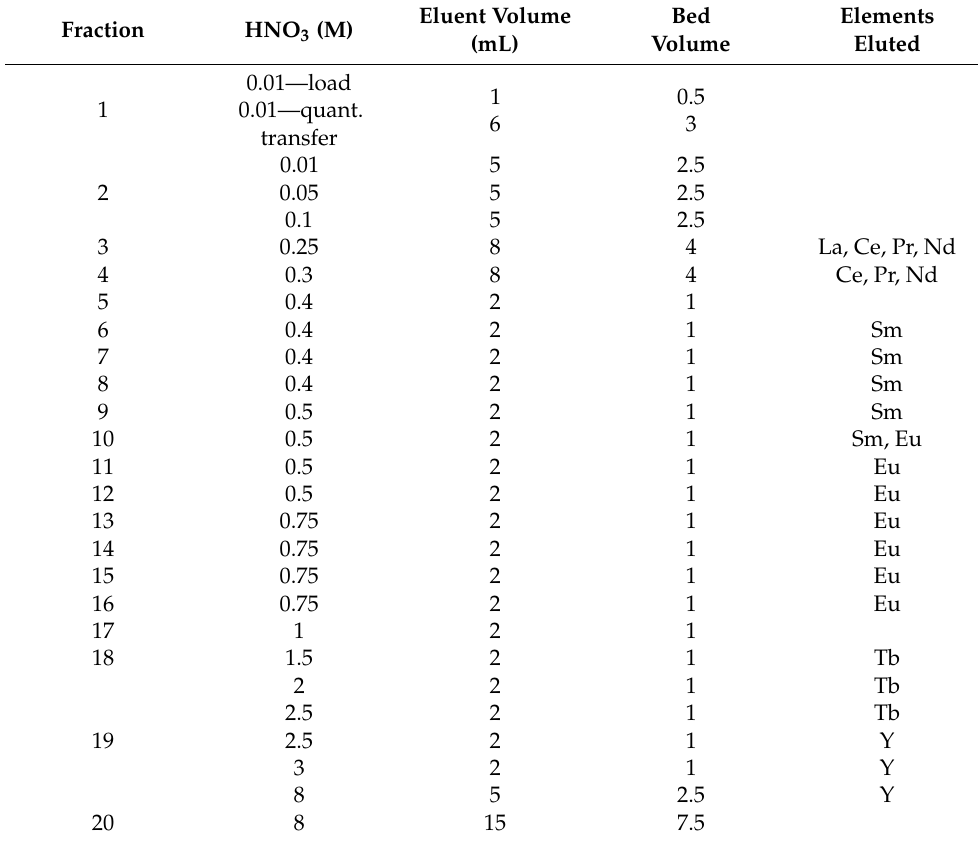
Table 1. Gradient elution parameters for REEs separation using 0.78 g LN resin with 50-100 µ m particle size.